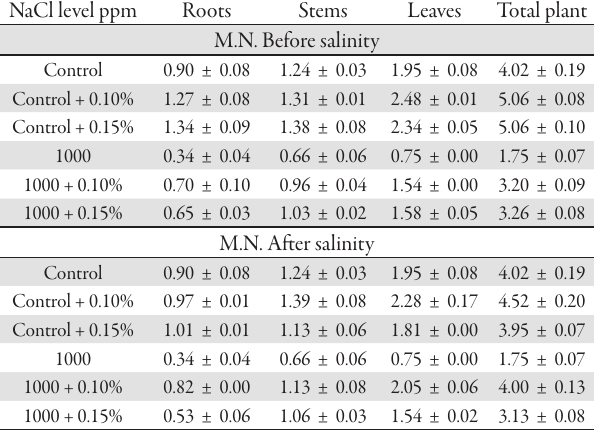
Tab. 2. Effect of micronutrient spraying before and after salinity treatments on the dry weight of faba bean plant